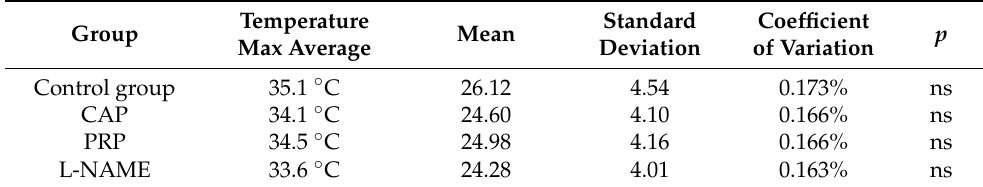
Figure 3. Thermographic images of the groups of rats included in the study. ( a ) Thermographic image of a control-group rat above the flap—print screen (PS). ( b ) Thermographic image of a CAP-group rat above the flap—PS. ( c ) Thermographic image of a L-NAME-group rat above the flap—PS. ( d ) Thermographic image of a PRP-group rat above the flap—PS. ( e ) Thermographic image of a CAP-group rat above the flap—PS. Table 1. Statistical interpretation of the data obtained from the processing of thermographic images (ns—non-significant).